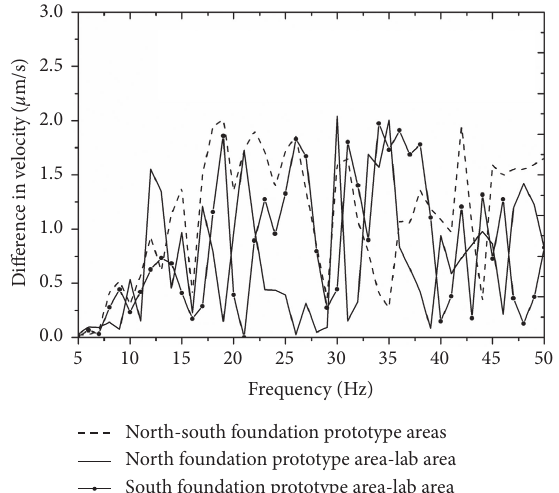
Figure 13: Difference in the velocities of free-field ground